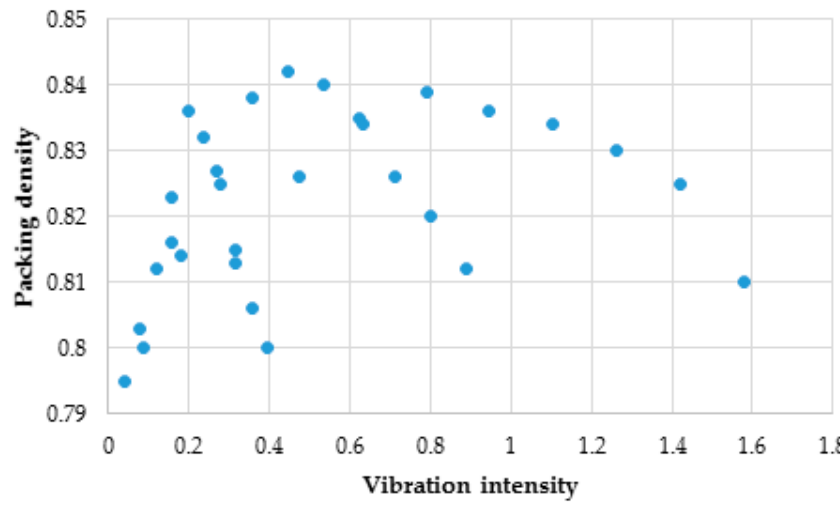
Figure 9. Packing density as a function of vibration intensity.